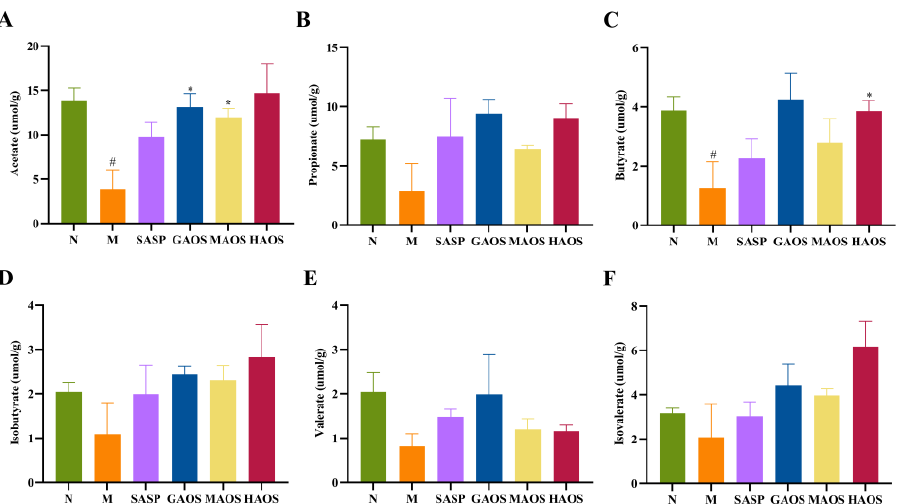
Figure 4. Effects of alginate oligosaccharides treatment on the SCFAs concentrations in DSS-induced mice. The concentration of ( A ) acetate, ( B ) propionate, ( C ) butyrate, ( D ) isobutyrate, ( E ) valerate, and ( F ) isovalerate in the cecal contents. Data were mean ± SEM ( n = 8). # p < 0.05 vs. the N group; * p < 0.05 vs. the M group.